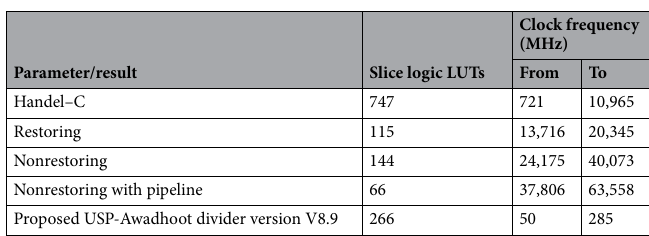
Table 2. Comparative analysis of the resource utilization of the proposed USP-Awadhoot algorithm-based divider with those of the Handle-C and digit recurrence algorithm-based dividers.